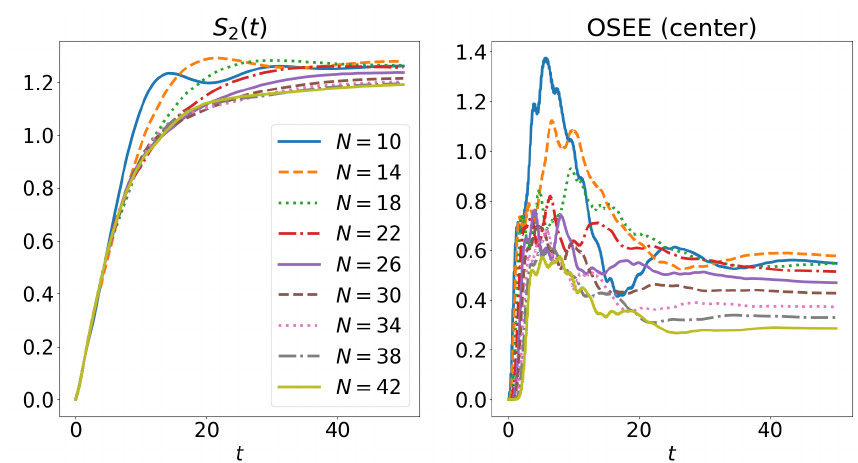
Figure 7: The second Rényi entropy S (left), and the operator-space entanglement 2 entropy for a bipartition of the system in its center (right), vs. the time t . The so- lutions are presented for N between 10 and 42 in a configuration with alternating qubit frequencies similar to that of Fig. 6 (but extended), and the parameters are given in Eqs.